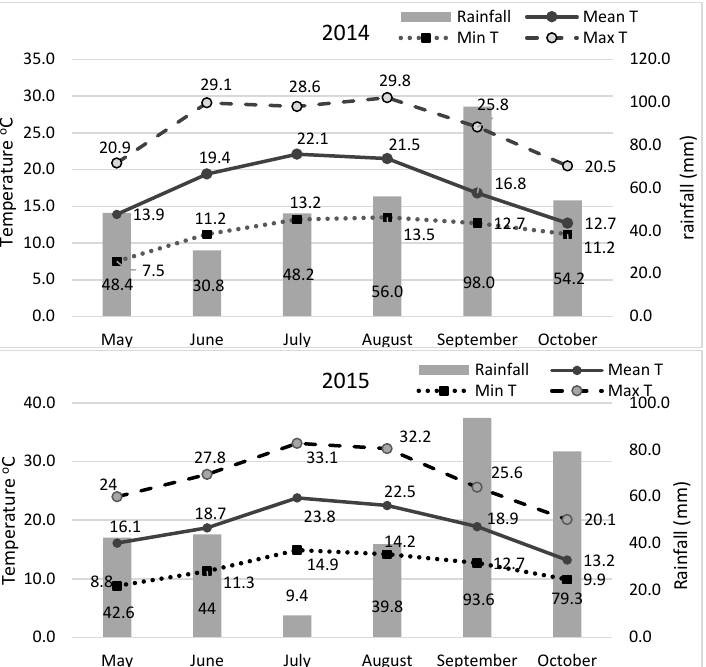
Figure 4. Climatic conditions during the two successive cultivation periods during the years 2014 and 2015.